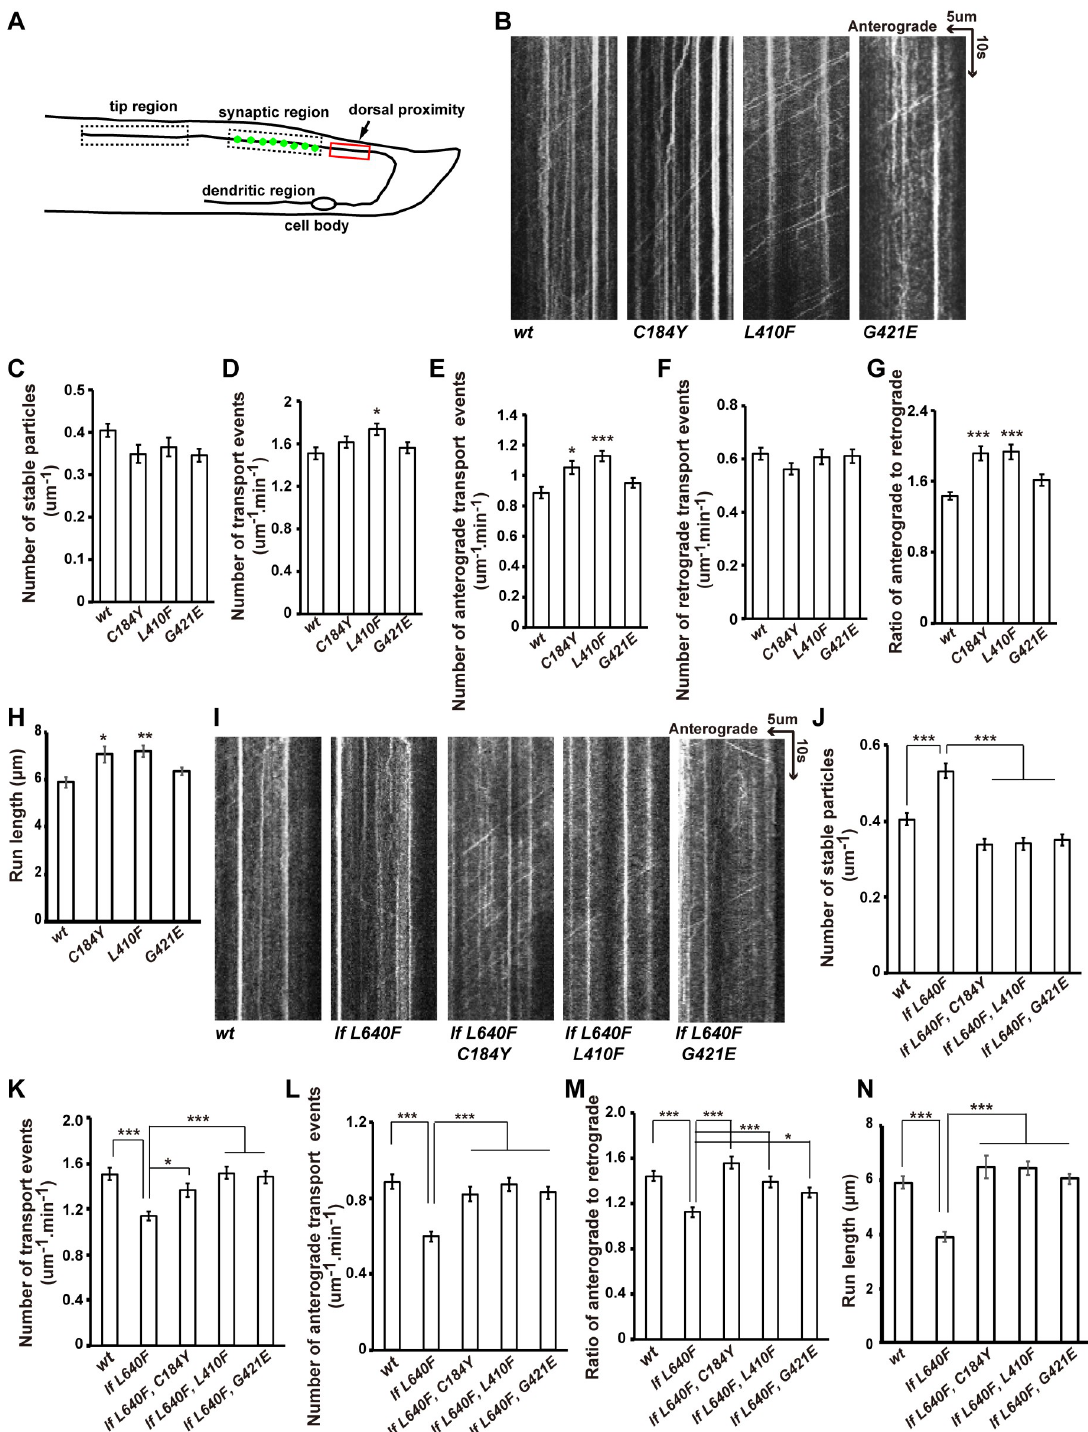
Fig 3. Synaptic vesicle transport is more active in suppressor mutants. (A) Schematic drawing of the wild-type DA9 neuron. Kymograph analysis was performed in the dorsal proximity region. (B) Representative kymograph images showing transport events in wild type ( wt ), unc-104(C184Y) , unc-104(L410F) and unc-104(G421E) . Time and length are on the y axis and x axis, respectively. (C) The number of stable GFP::RAB-3 particles in a 1- μ m section within 1 min. (D) The total number of transport events (anterograde plus retrograde) was measured by counting the number of GFP::RAB-3 particles that passed through this 1- μ m zone during the 1-min